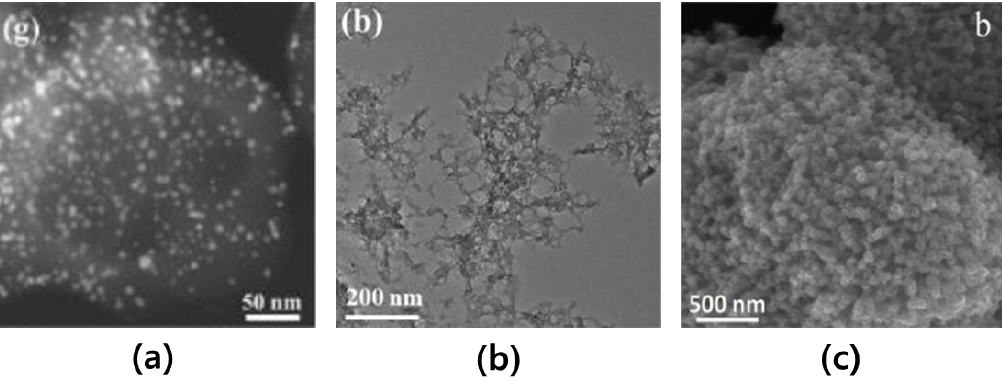
Figure 1. Examples of microscopic images in material science documents: ( a ) represents the STEM image of Au nanoparticles. reprinted with permission from Ref. [12]. Copyright (2020) Elsevier; ( b ) represents the TEM image of Co 8 Fe 2 -MOF. reprinted with permission from Ref. [13]. Copyright (2021) Elsevier; and ( c ) represents the SEM image of S/PCMSs composites. reprinted with permission from Ref. [14]. Copyright (2019) Elsevier. Table 1. List of various image inpainting methods in the field of computer